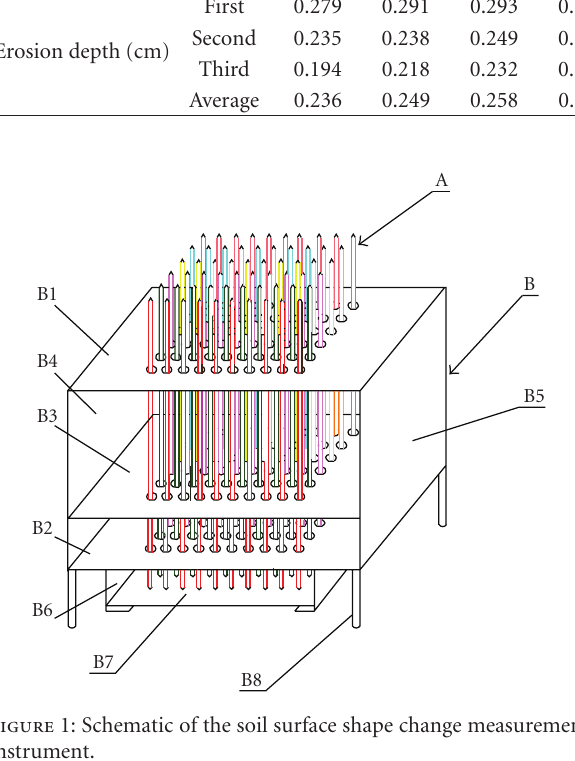
Figure 1: Schematic of the soil surface shape change measurement instrument.